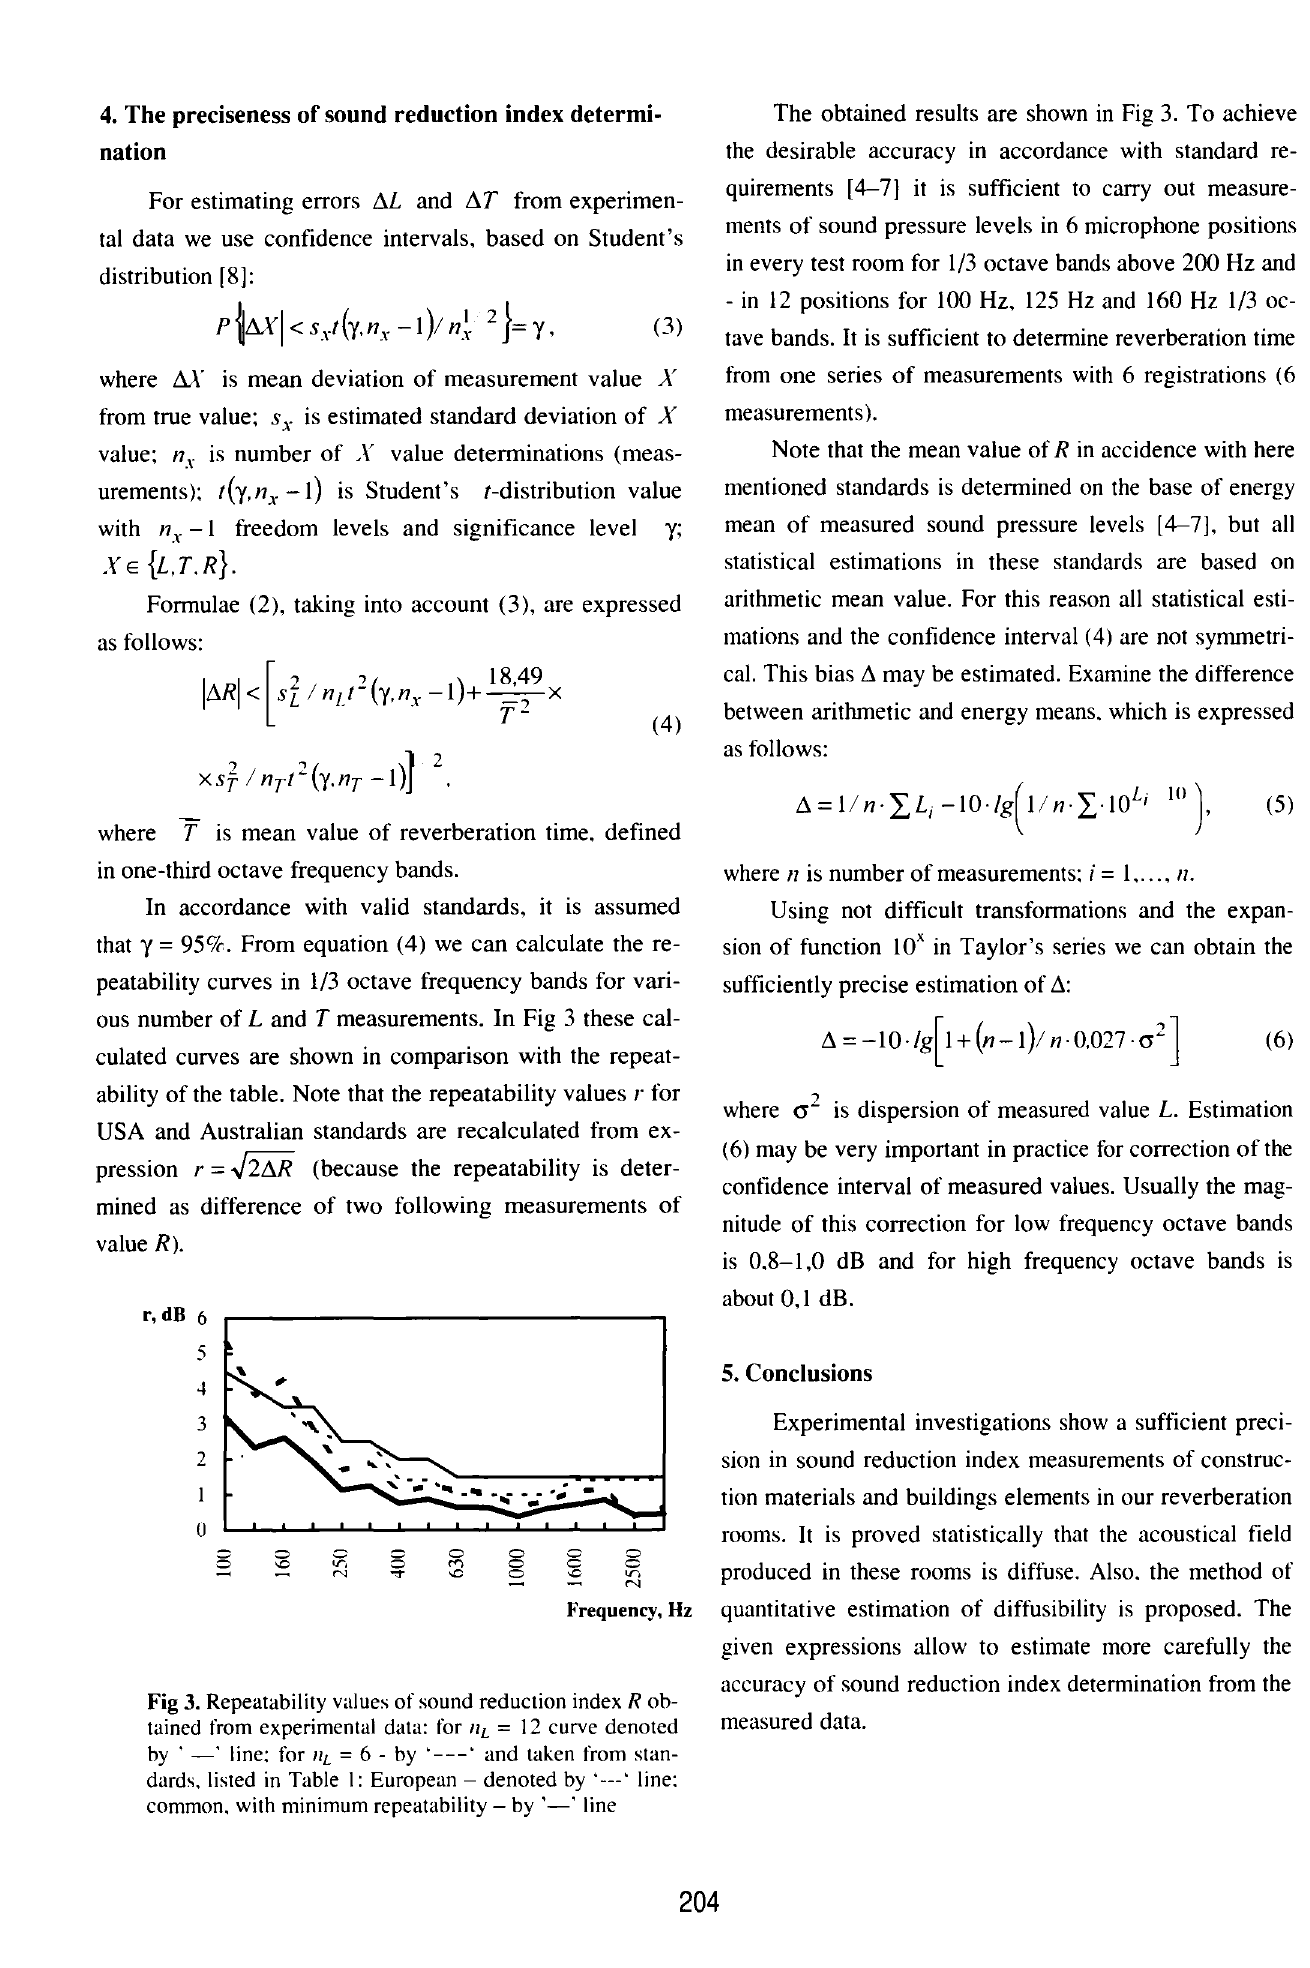
Fig 3. Repeatability values of sound reduction index Rob tained from experimental data: for IlL = 12 curve denoted by '-· line: for IlL= 6- by ·---· and taken from stan dards. listed in Table 1: European - denoted by · ---· line: common. with minimum repeatability- by·-· line